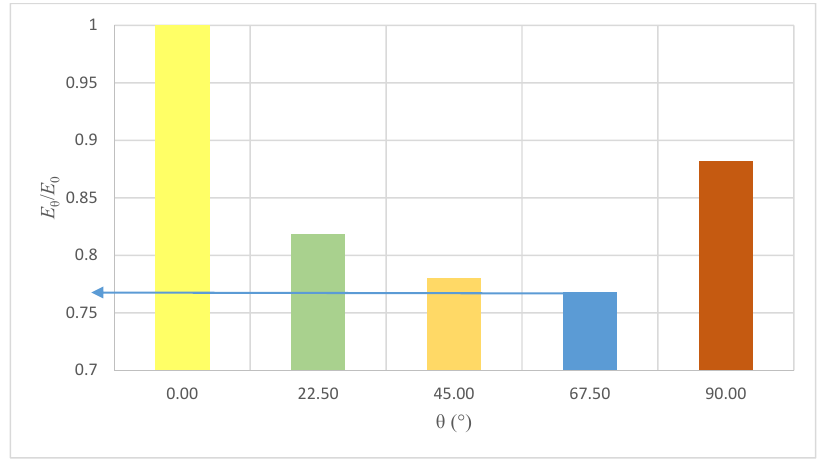
Figure 9. Changes in Young’s modulus coefficient E θ /E 0 in regard to the angle of the head joints angle θ . The lowest value of the coefficient E θ /E 0 has been obtained for samples with joints rotated at an angle θ = 67.5°.